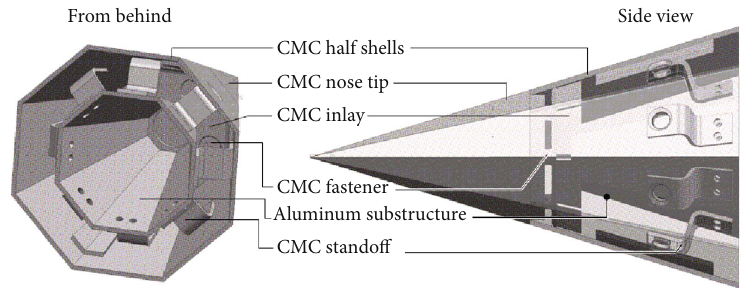
Figure 8: SHEFEX II C/C-SiC sharp leading-edge design.